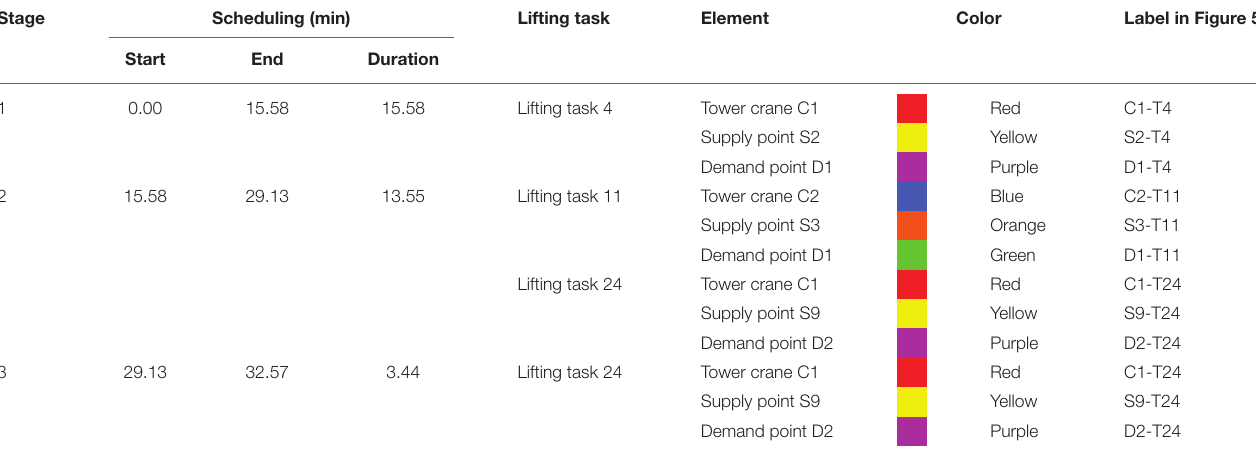
TABLE 7 | Stage information adopting the normal-level scheme.